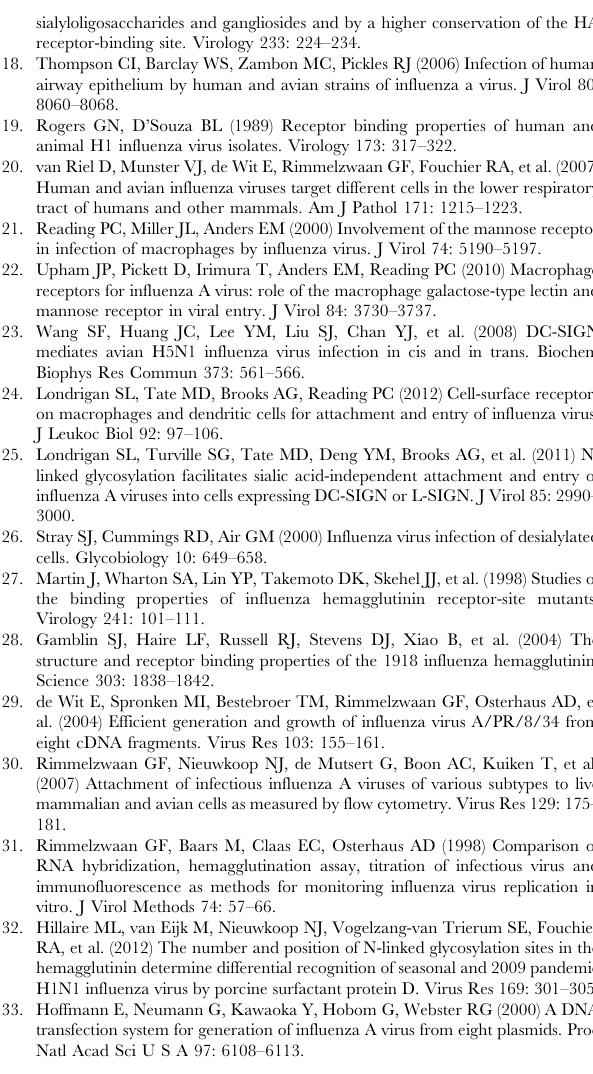
mixture of biotin-labelled lectins SNA and MAA and subsequently with FITC-labelled streptavidin, the removal of sialic acids was confirmed by flow cytometry (in grey). The dotted line represents unstained cells and the black line cells represent the background staining of cells that were incubated with FITC-labelled streptavidin only. Figure S2 Comparison of infection rates of MDCK and Vero cells with those expressing DC-SIGN after inoculation with 13 different viruses used in the present study at a multiplicity of infection of 2 TCID 50 per cell. Each symbol represents an individual virus. These infection rates were used to calculate the ‘‘percentage of infection compared to positive control’’ showed in figure 5 and